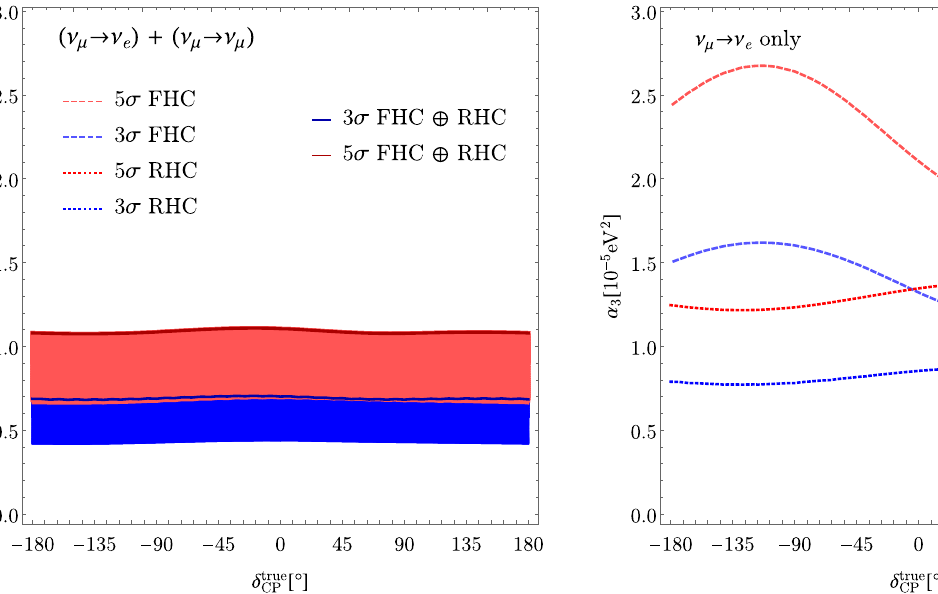
Fig. 4 Sensitivity to α 3 as a function of θ true combining ν μ disappearance and ν e appearance, after both FHC and RHC runs. The curves show the sensitivity after marginalizing over